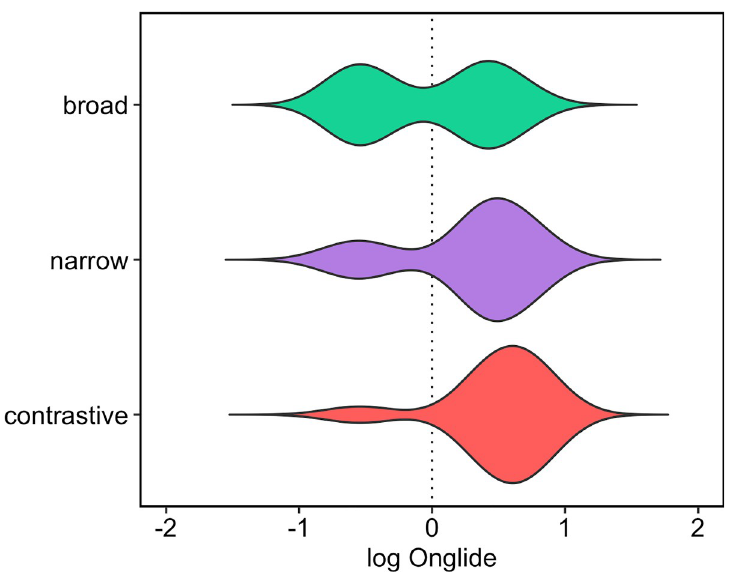
Fig 10. Distributions of normalised onglide values pooled across all speakers.